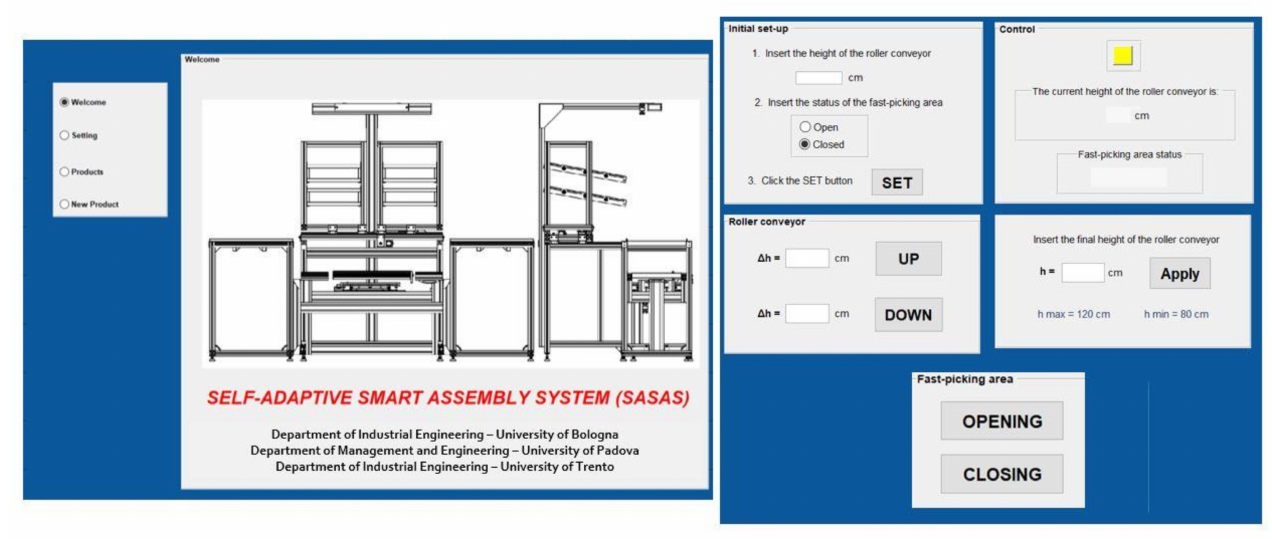
Figure 4. Graphic user interface (GUI) for the real-time control and